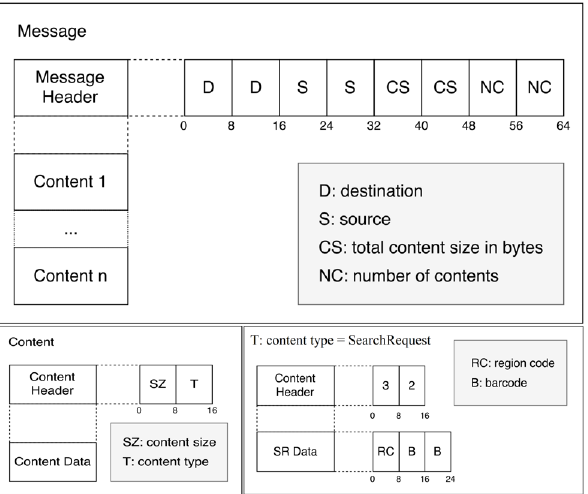
Figure 13. Diagram showing the structure of messages and the content of those